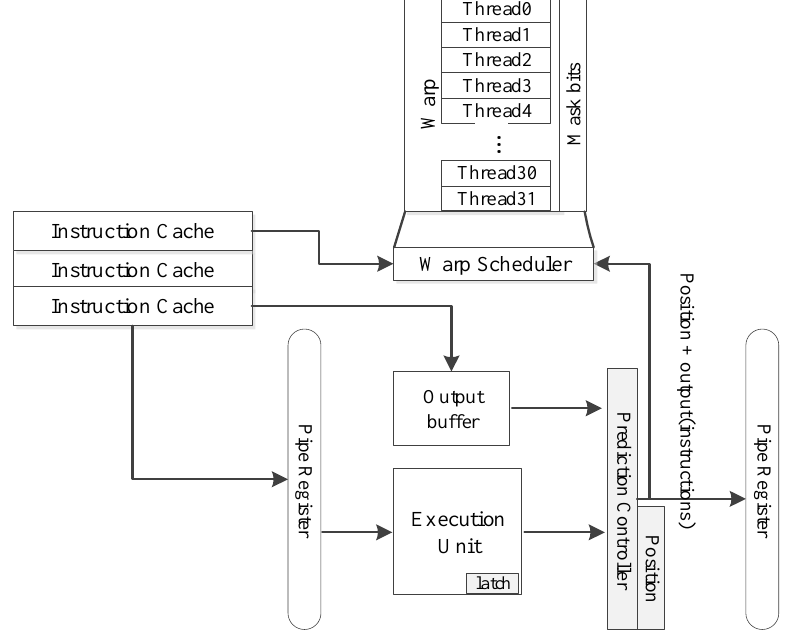
Figure 5. Prediction flow with pipeline registers.